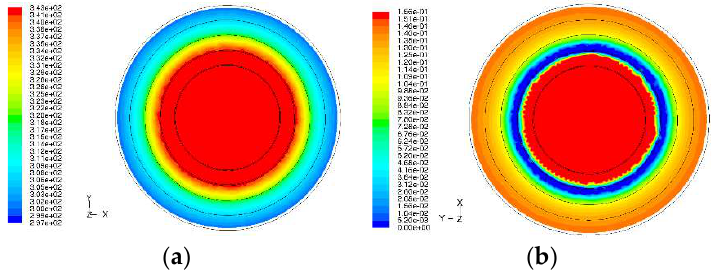
Figure 9. The cross-section representations for the second simulation version (v = 2 m/s; T = 343 K = 70 °C). ( a ) Temperature field (K); ( b ) absolute humidity field (kg water vapors/kg dry product) [20].